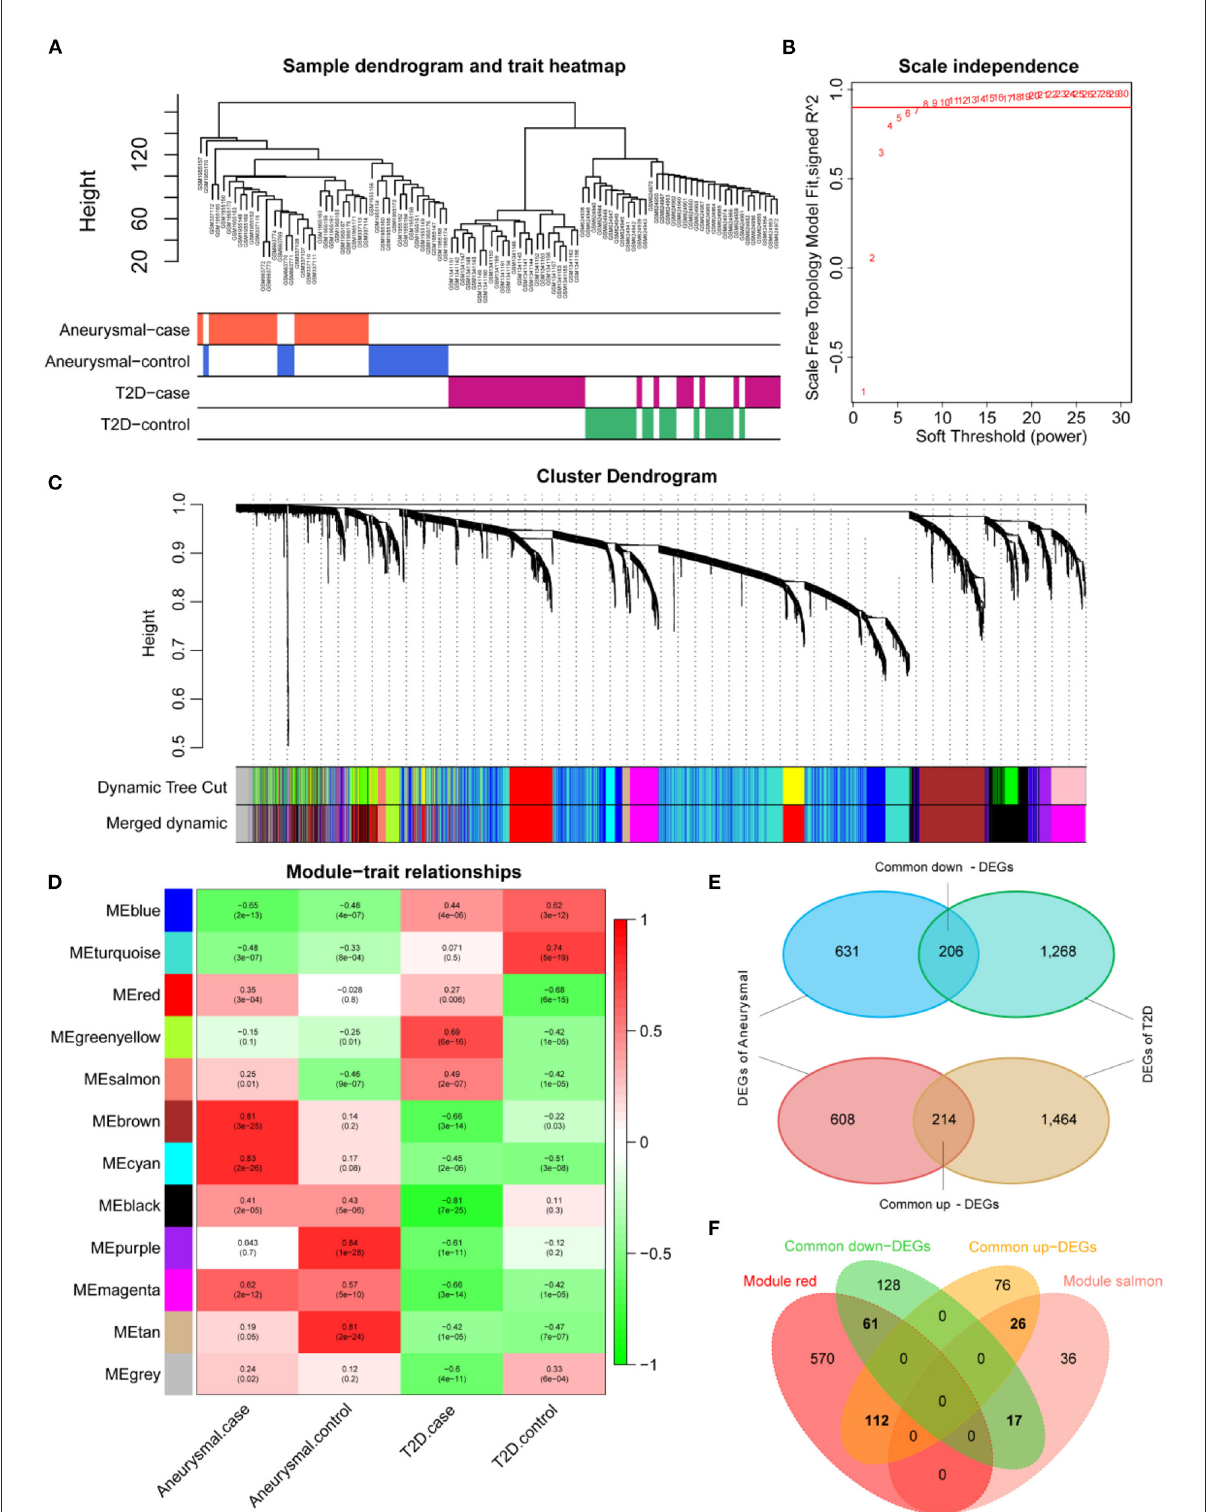
FIGURE2 Screening of target genes. (A) Dendrogram of clusters for all the samples. (B) R 2 of scale-free model fit analysis corresponding to different soft threshold values; R 2 of the red horizontal line is 0.9. (C) Dendrogram of the genes in the top 25% of the standard deviation based on dissimilarity measure (1-TOM) clustering; color bars are used to mark different modules. (D) Heat map of correlation between module eigengenes (ME) and clinical phenotypes; red and salmon modules are significantly correlated with both intracranial aneurysm (IA) and type 2 diabetes mellitus (T2DM). (E) Venn diagram of differentially expressed genes (DEGs) for IA and T2DM. (F) Venn diagram of common DEGs for IA and T2DM with red and salmon modules, in which 216 genes were considered as significant target